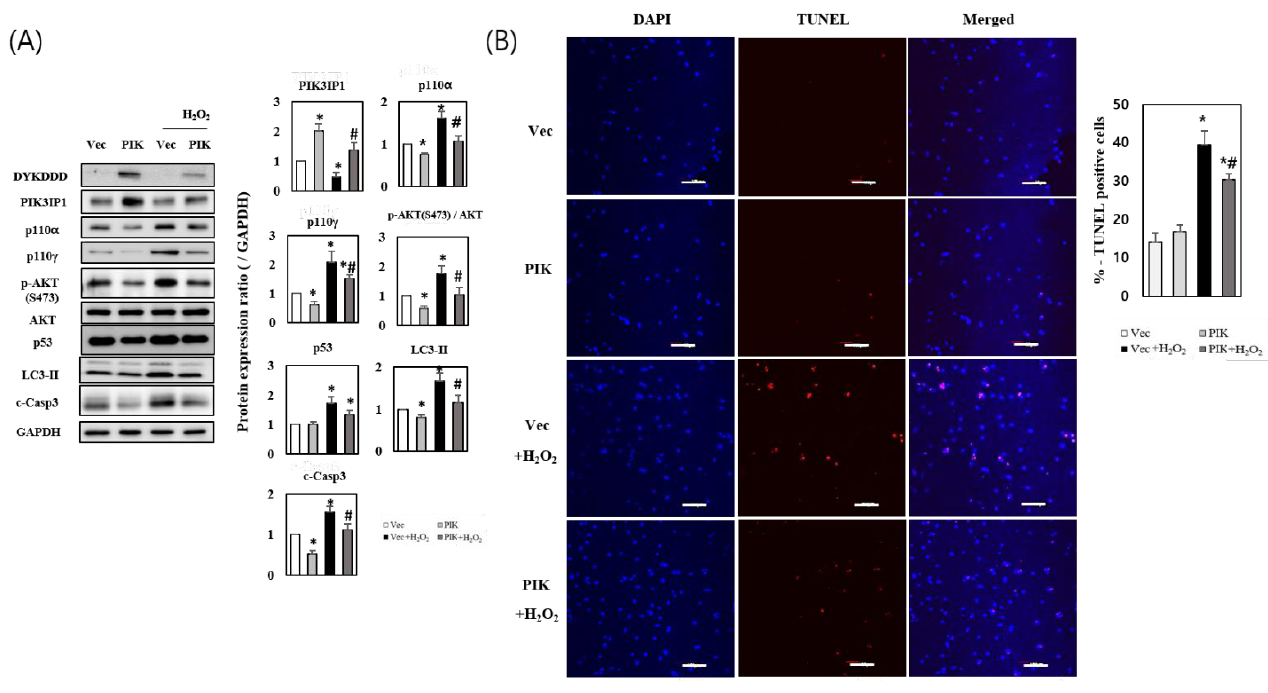
Figure 2. PIK3IP1 overexpression inhibits H 2 O 2 -induced cell death via downregulation of p110α,